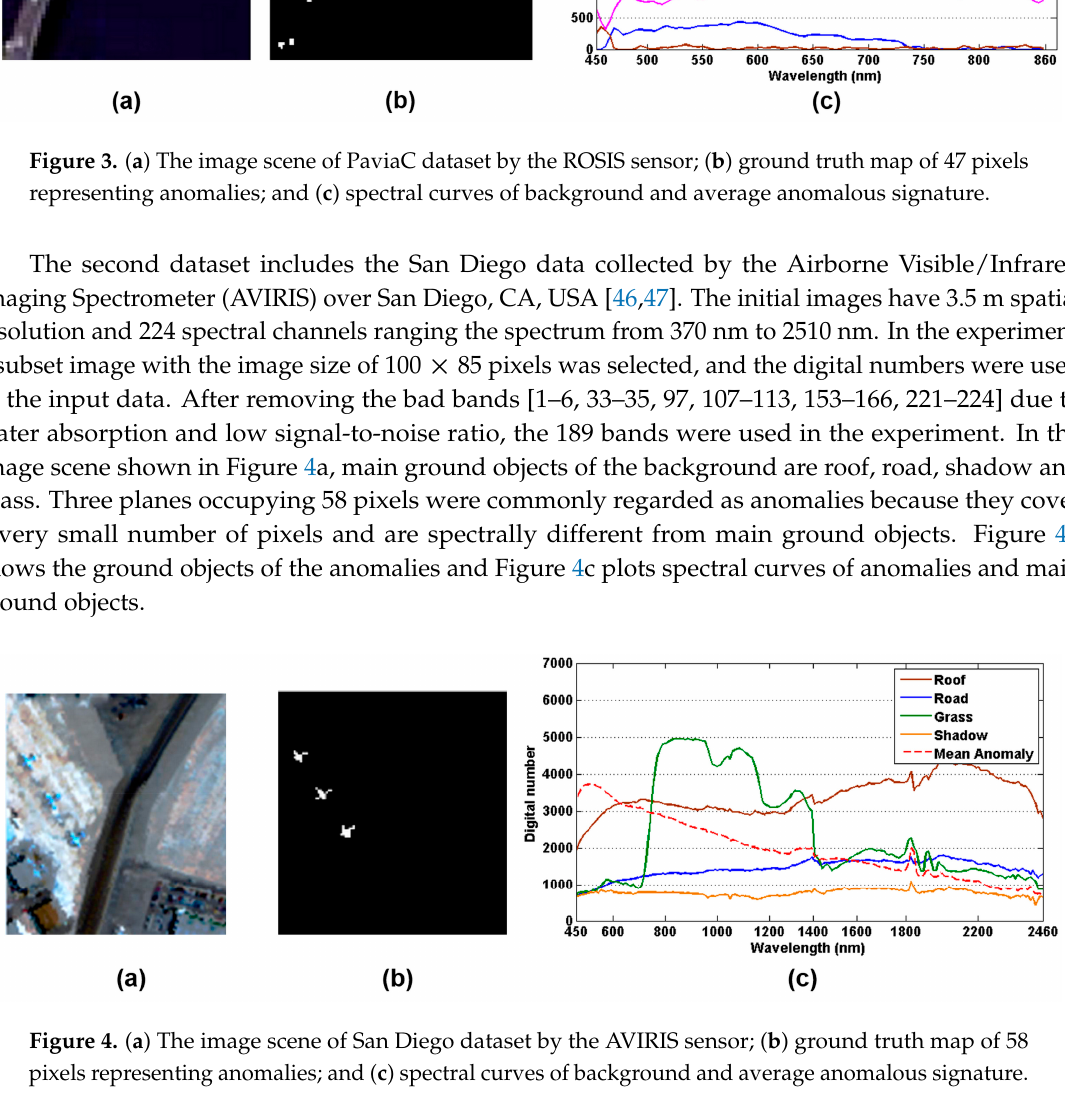
Figure 4. ( a ) The image scene of San Diego dataset by the AVIRIS sensor; ( b ) ground truth map of 58 pixels representing anomalies; and ( c ) spectral curves of background and average anomalous signature.